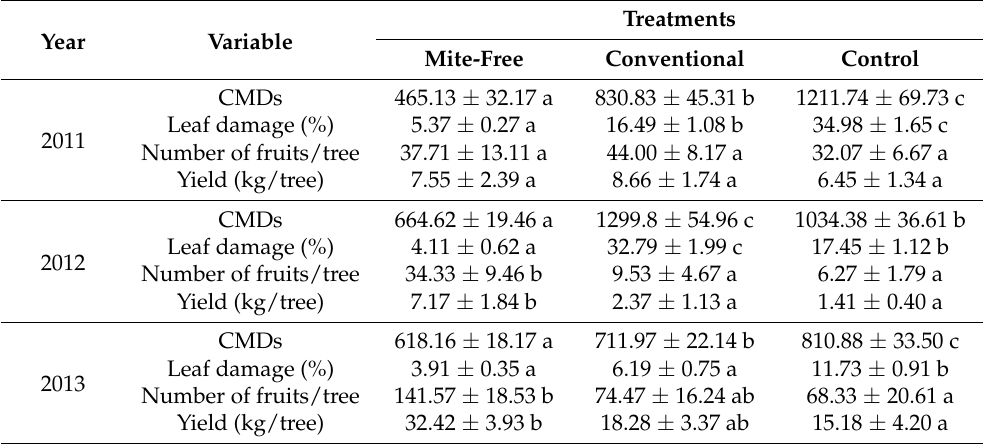
Table 4. Mean ( ± SE) of CMDs, leaf damaged area (%), number of fruits per tree, and yield (kg) for avocado trees subjected to three treatments in Tenerife. Different letters mean significant differences (Tukey’s HSD multiple range test, p <